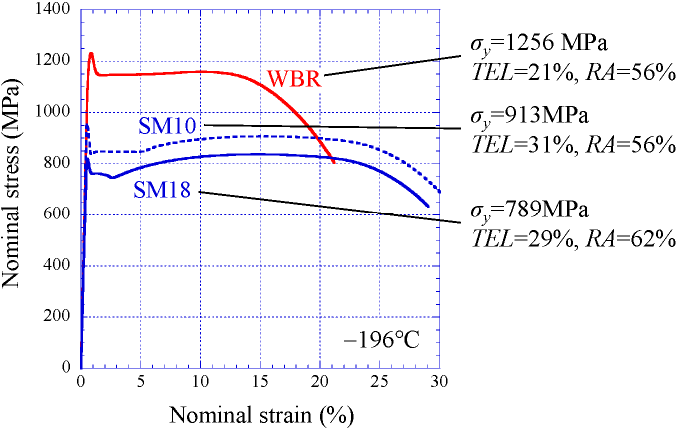
Figure 6. Nominal stress–nominal strain relations. Here, σ y , TEL , and RA denote yield stress, total elongation, and a reduction in area, respectively.